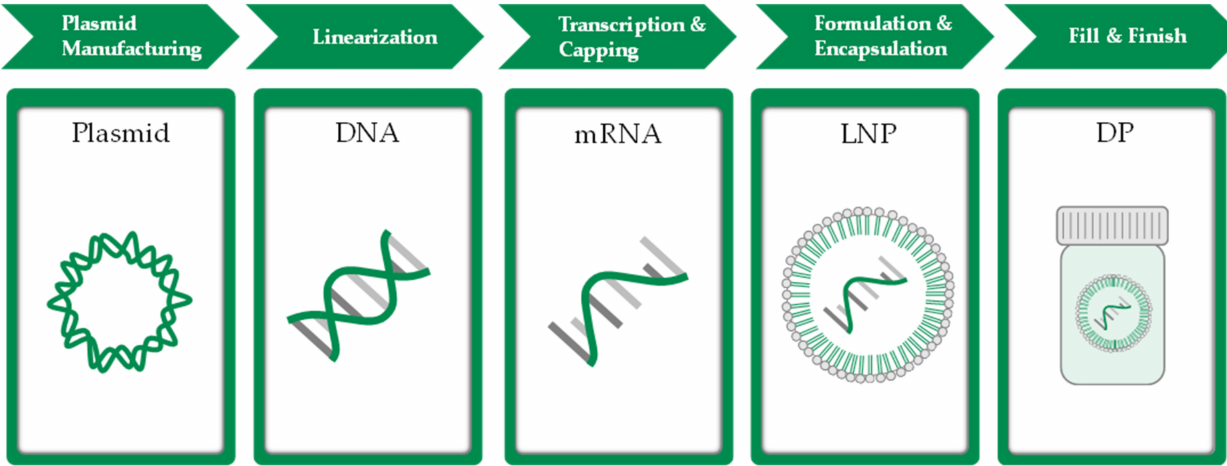
Figure 3. Main process phases and intermediates in mRNA vaccine manufacturing. Synthesis of mRNA needs, as a starting, point template DNA that contains the genetic code for the respective spike protein. State-of-the art is still plasmid manufacturing by E. coli fermentation followed up by purification and linearization. In the next phase the linearized DNA serves as template during in-vitro transcription, capping and formulation including encapsulation of mRNA in